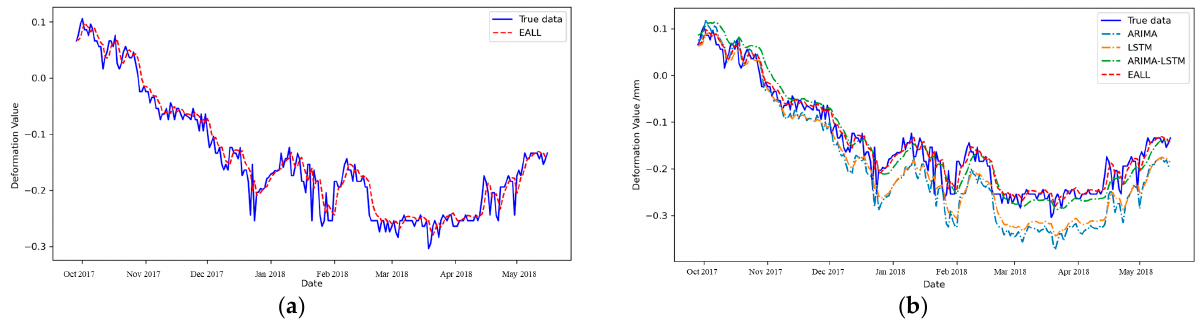
Figure 8. Prediction results of the model. ( a ) Prediction results of EALL model; ( b ) Comparison of prediction results of various models.